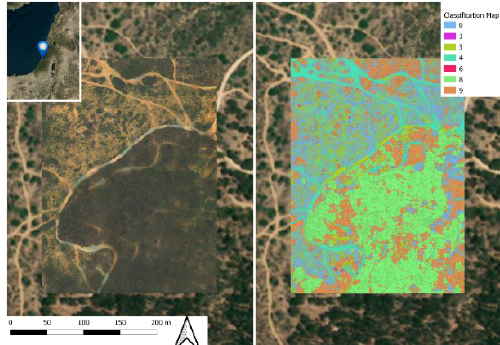
Figure 9. Extract of land cover map obtained with methodology developed by the geomatics group of the Politecnico di Torino.